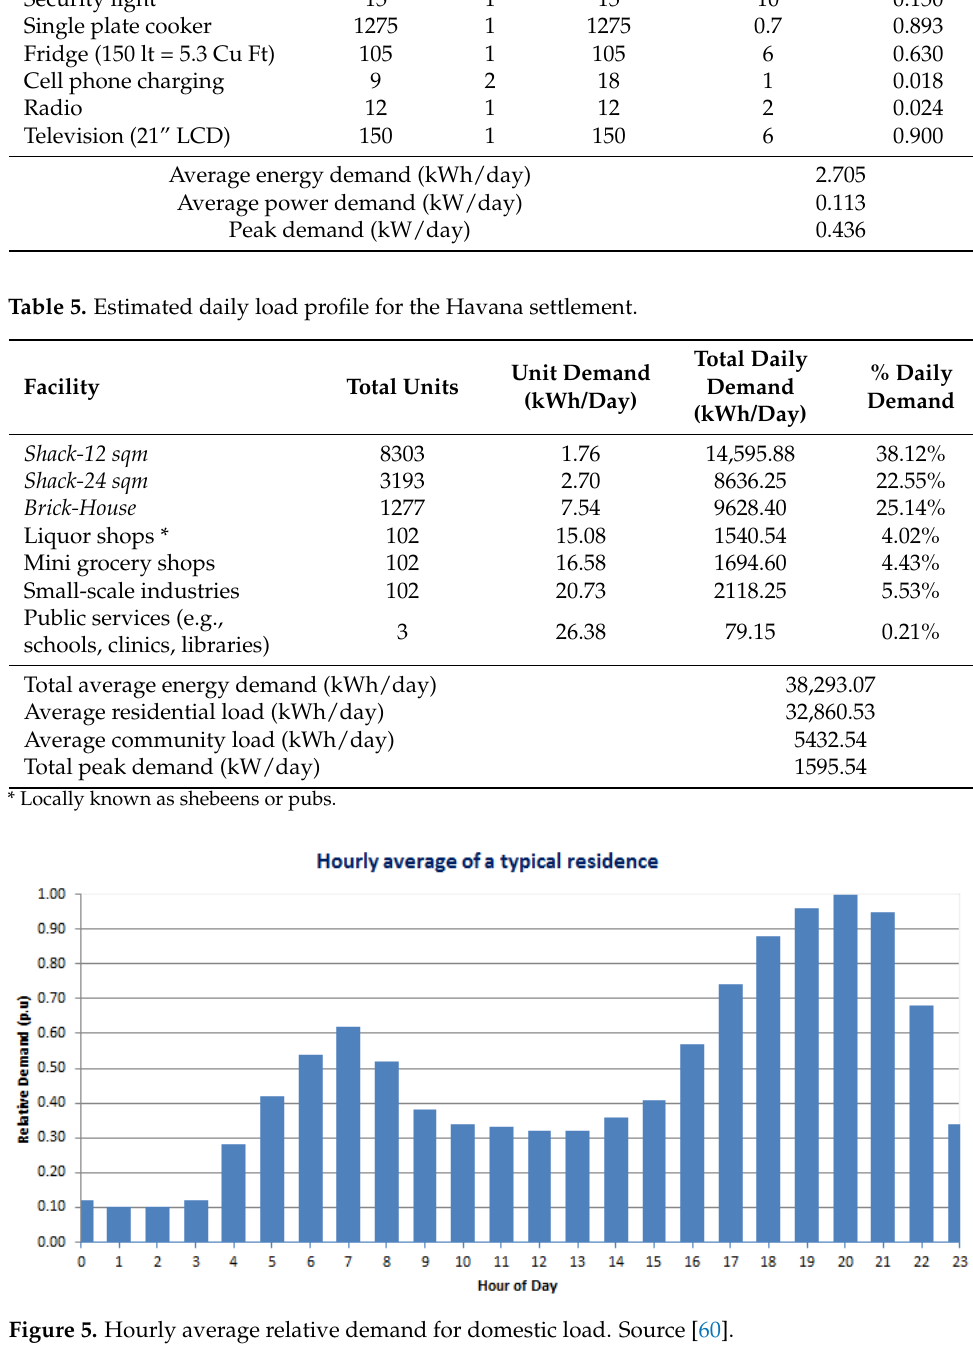
Figure 6. Hourly average relative demand for commercial load. Source [60].